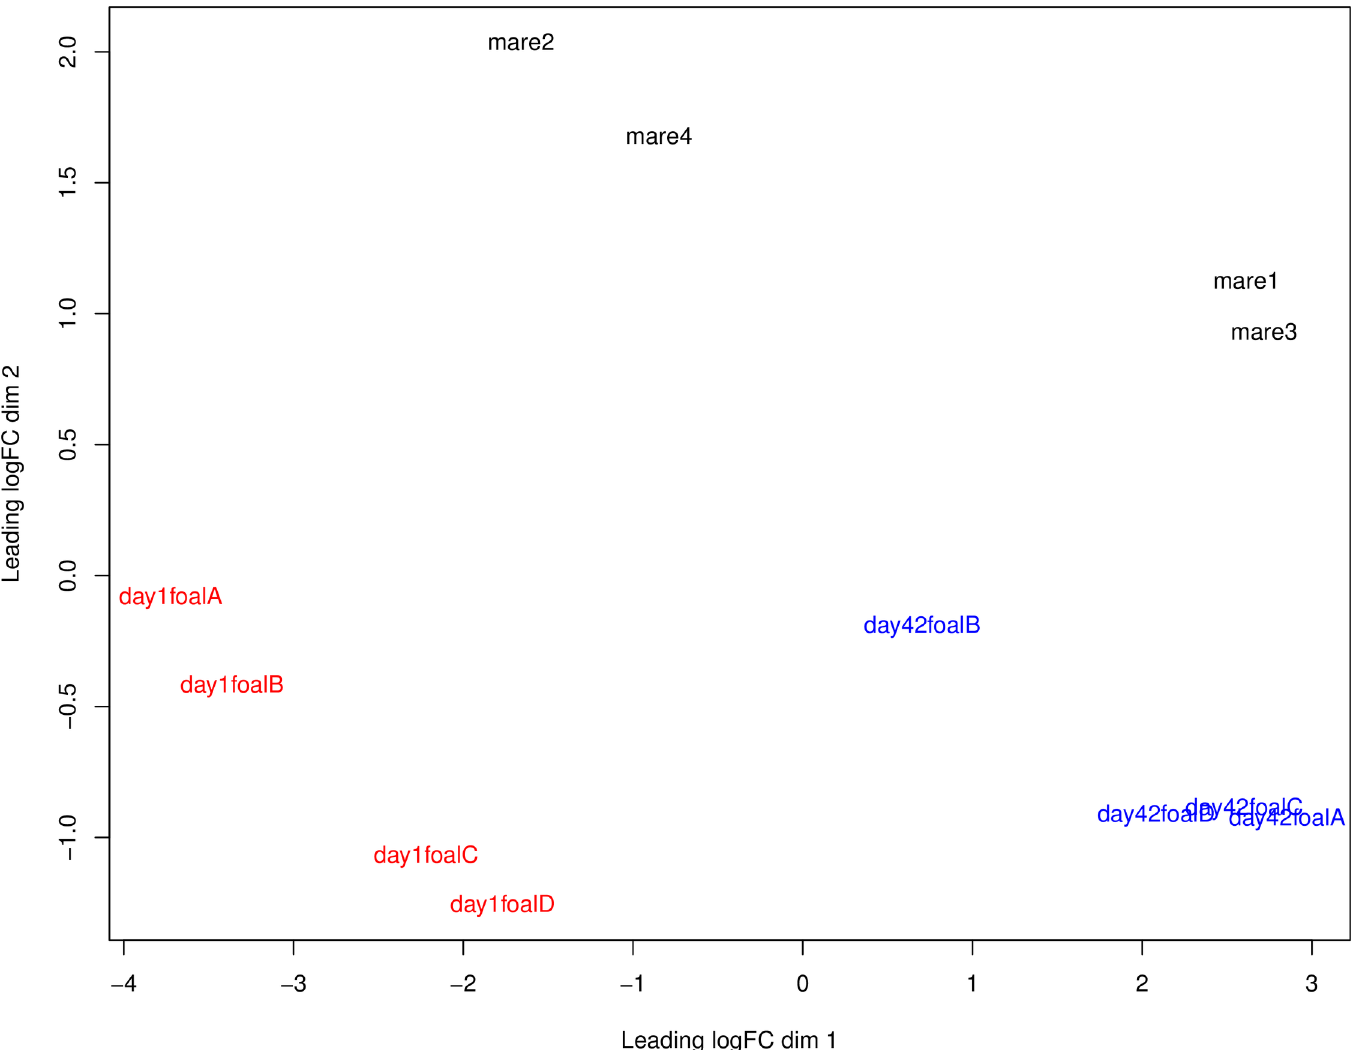
Fig 1. Multidimensional scaling plot of peripheral blood mononuclear cell transcriptome profiles. The transcriptome profiles of day 1 samples are shown in red font, those of day 42 foal samples are shown in blue font, and adult sample profiles are displayed in black font. The correlation among samples within age groups was (cid:21) 0.72.